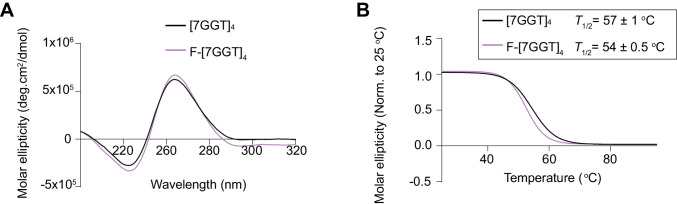
Properties of tetrameric G4 with added FRET dyes.(A) Circular dichroism (CD) spectra of 10 µM fluorophore-modified F-[7GGT]4 and unmodified [7GGT]4. (B) Thermal stability of modified and unmodified [7GGT]4, measured using CD at 260 nm. Since intermolecular G-quadruplexes reform very slowly and are therefore not at equilibrium during the measurement, we refer to this value as T½ rather than Tm, which is the true thermodynamic parameter at equilibrium. Mean ± SD of 3 independent experiments.